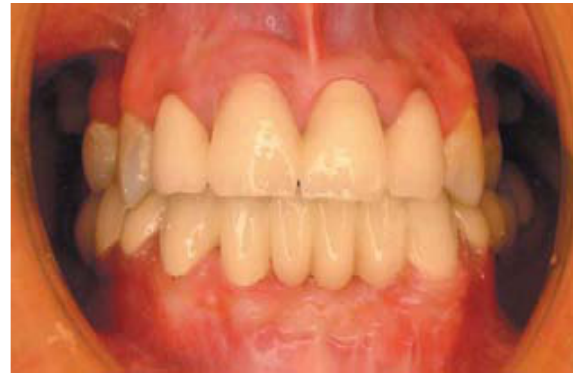
Figure 7- Clinical view of the definitive